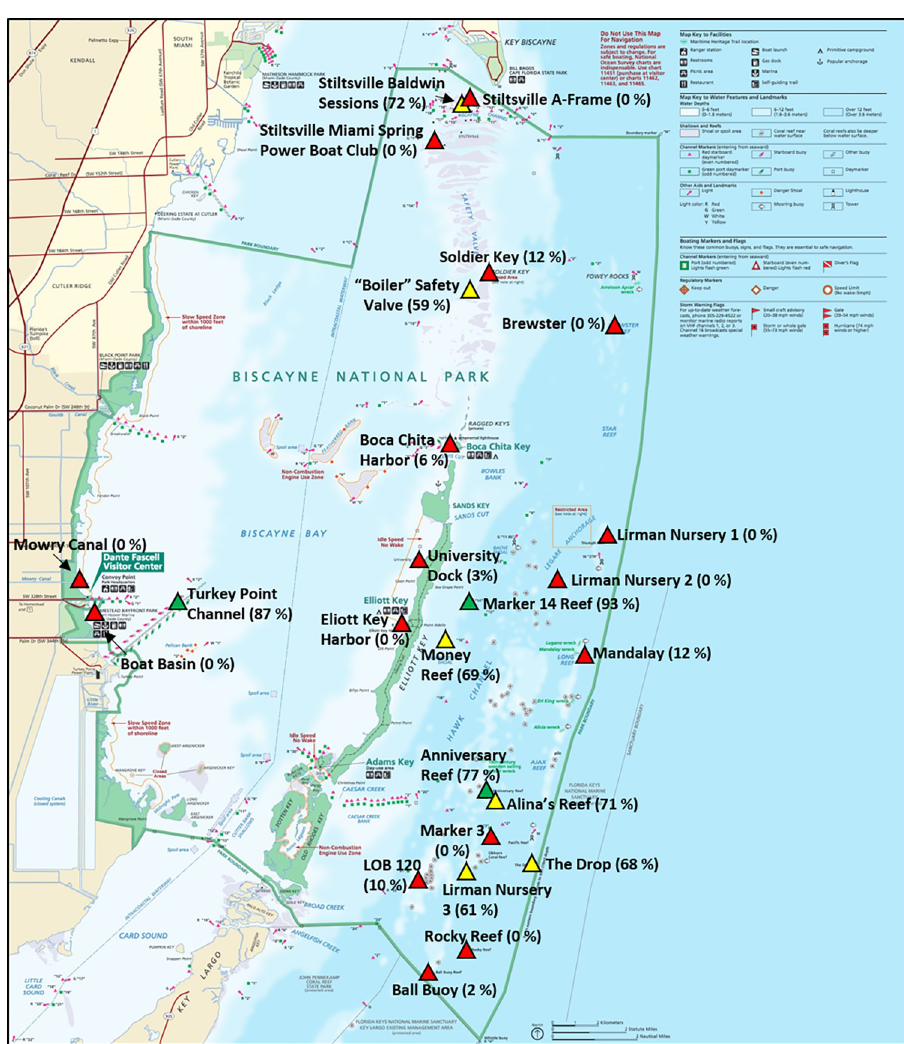
Fig 3. Map of Biscayne National Park sediment sampling sites with toxicity assay results. Non-impacted sites = green triangles; impacted sites = yellow triangles and toxic sites = red triangles. Mean percent normal sea urchin embryo development is in parentheses following the site name. Park boundary = solid green line. (Map source: National Park Service, public domain).